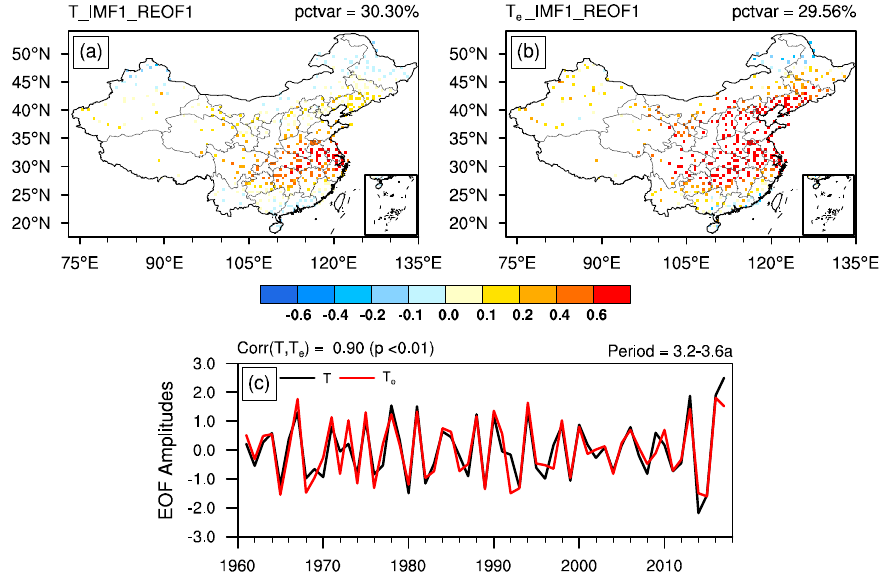
Figure 2. The first rotated empirical orthogonal function (REOF) modes of the intrinsic mode functions (IMF) 1 of summertime T ( a ) and T e ( b ) in China, and the corresponding principal component ( c ). Note that the “pctvar” in the figure means percent variance; “Corr” means correlation coefficient between T and T e ; Black (Red) line represents the principal component of T ( T e ).